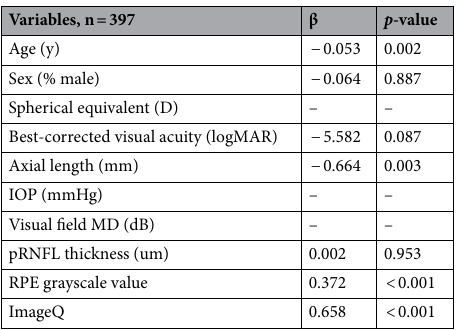
Table 4. Multivariable analysis between ocular and systematic factors with average pRNFL grayscale